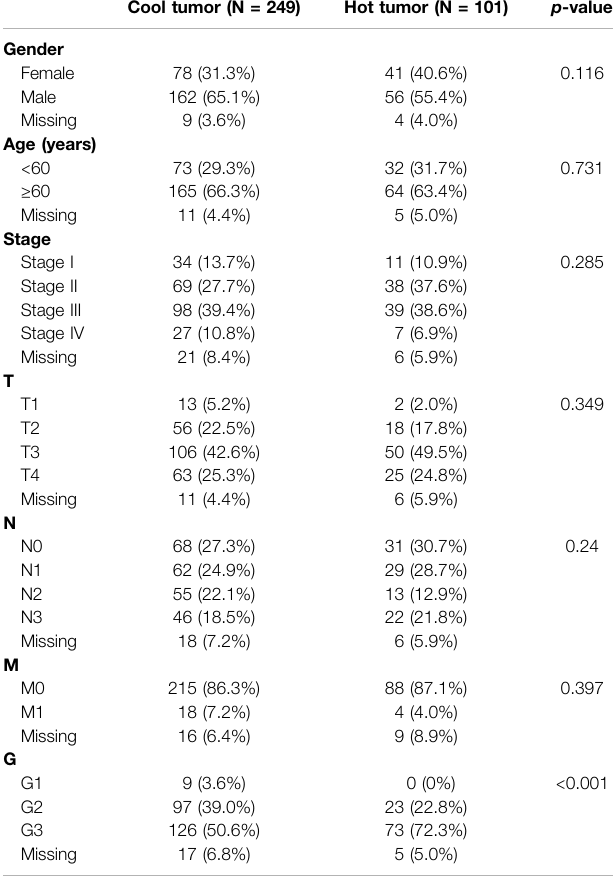
TABLE 1 | The differences on clinical phenotype between hot and cold